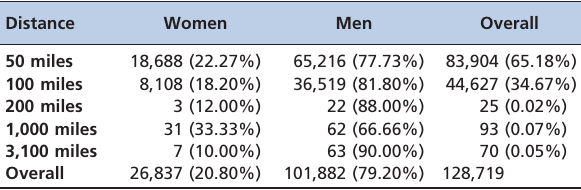
Table 1 - Overall finishers up to 2012, sorted by sex and distance. Finishers per distance indicating the number of both male and female finishers, the percentage of finishers of events in brackets, and the overall finishers from 50 to 3,100